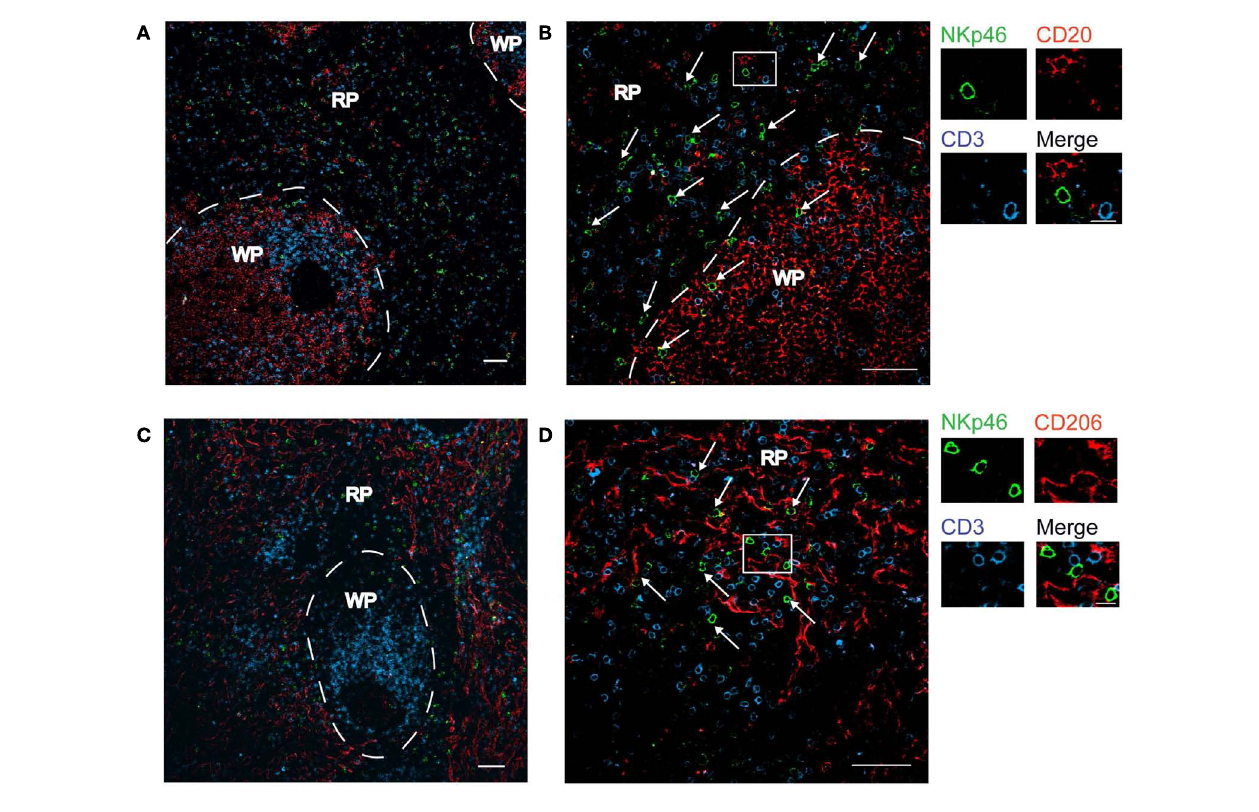
anti-CD3 mAb (blue) (C,D) .WP, white pulp; RP, red pulp. Arrows indicate NKp46 + CD3 − cells. Scale bar = 50 µ m. Data are representative of at least two independent experiments performed on three distinct